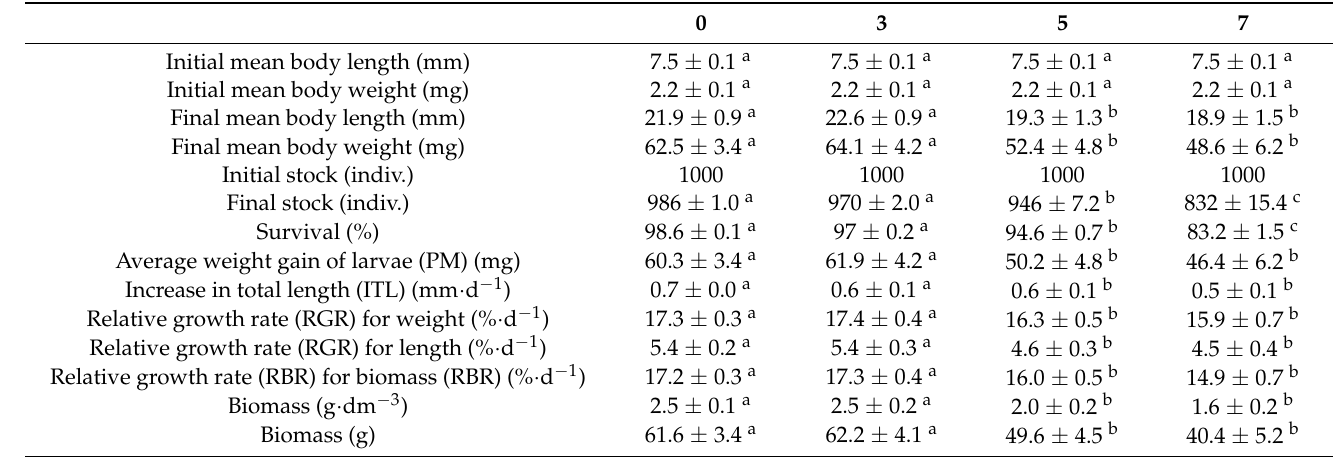
Table 1. Results of rearing the blue bream Ballerus ballerus (L.) larvae in freshwater and in water with salinity of 3, 5, and 7 ppt. Mean value ± SD. Results in rows with the same letter index are not statistically significantly different ( α = 0.05).